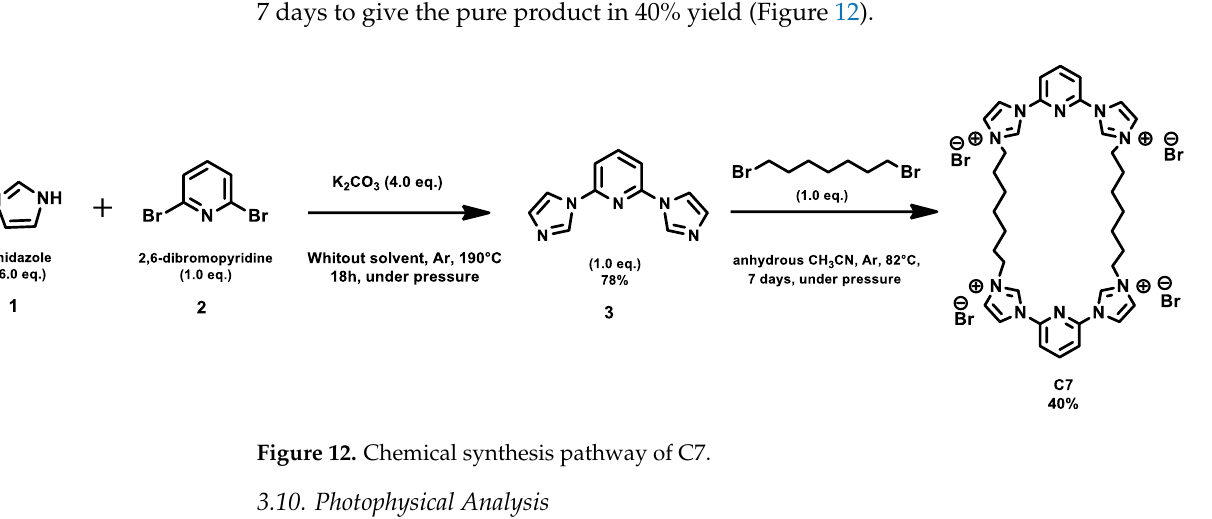
Figure 11. Optical density measured upon product incubation with human blood cells.